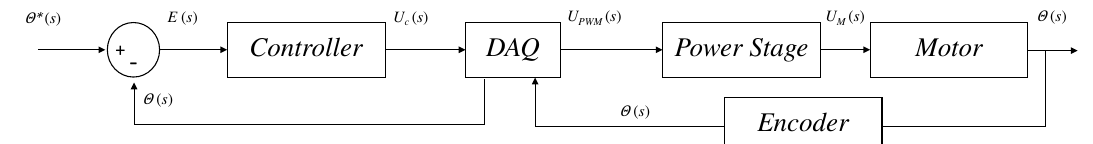
Figure 1. Control loop proposed for the project.